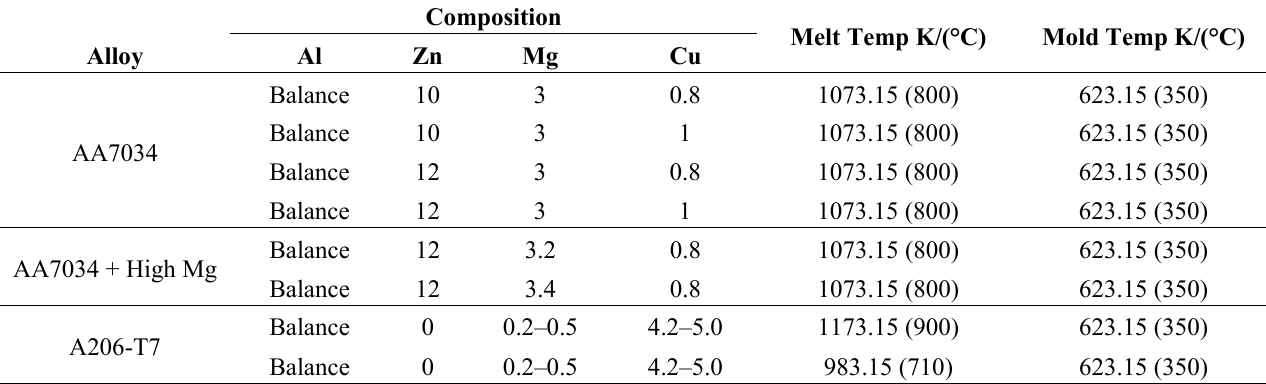
Table 1. Alloy compositions and processing